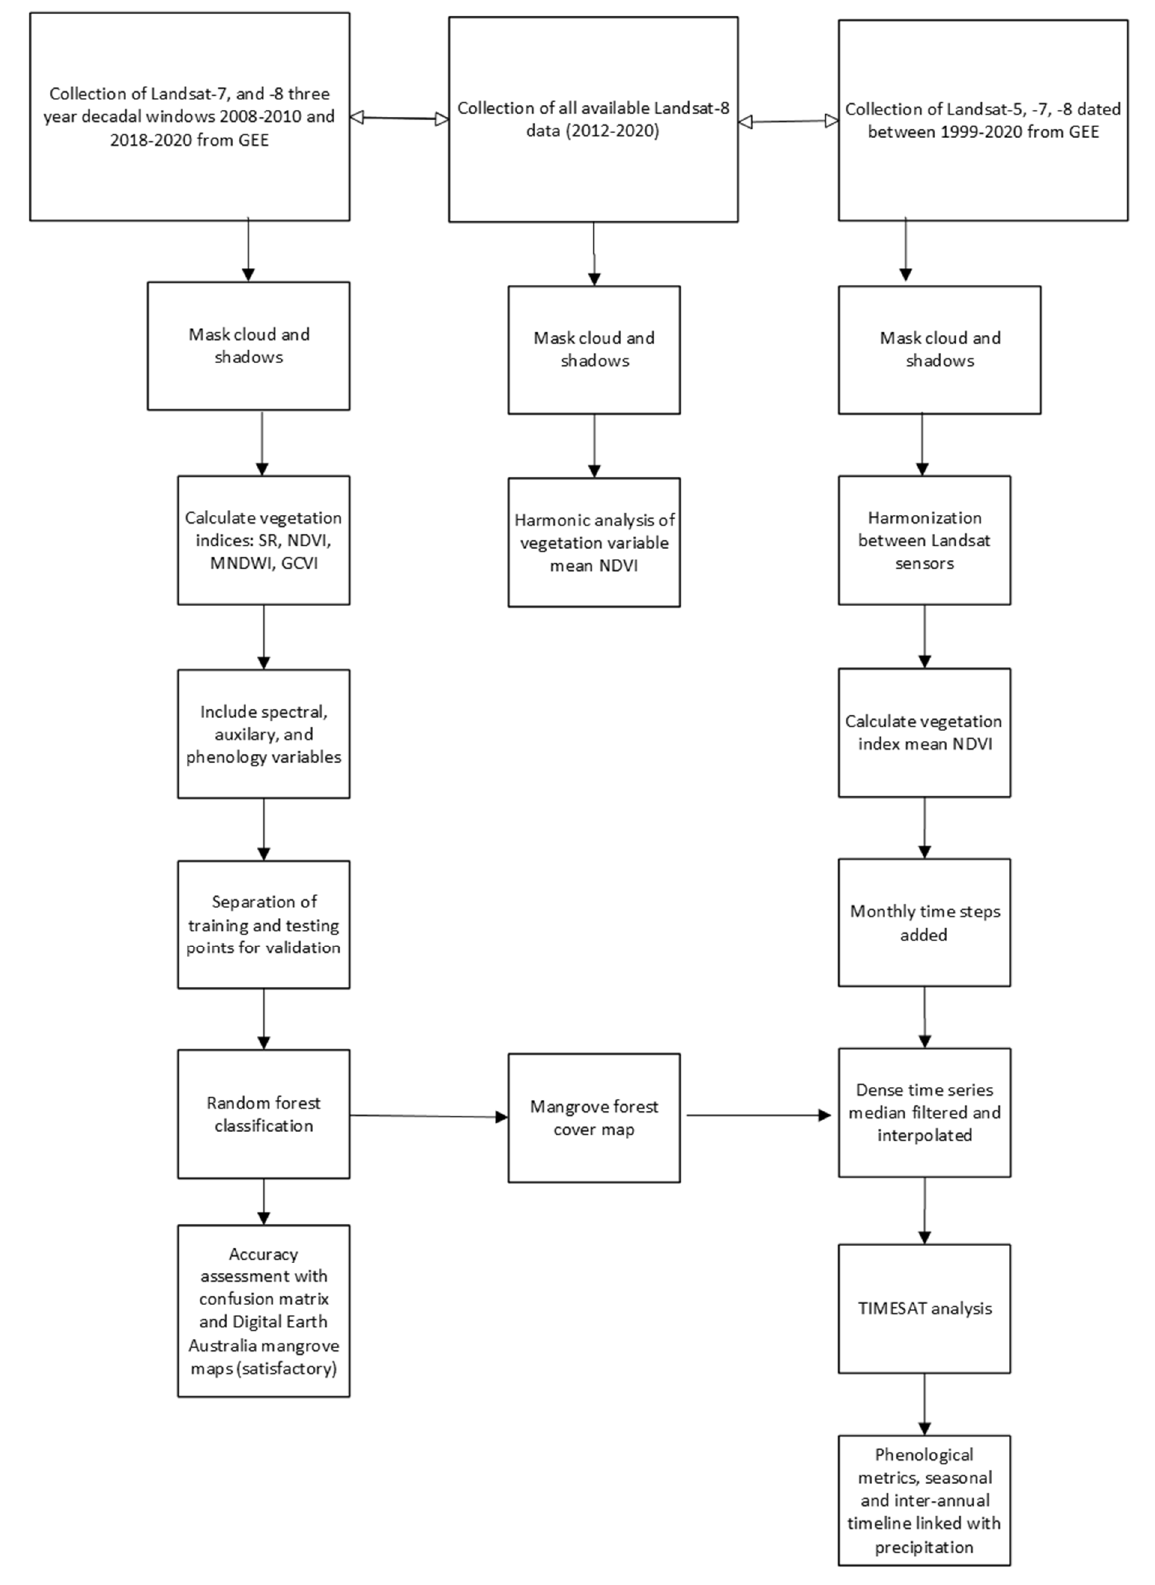
Figure 2. Workflow used for land cover classification and phenological analysis.